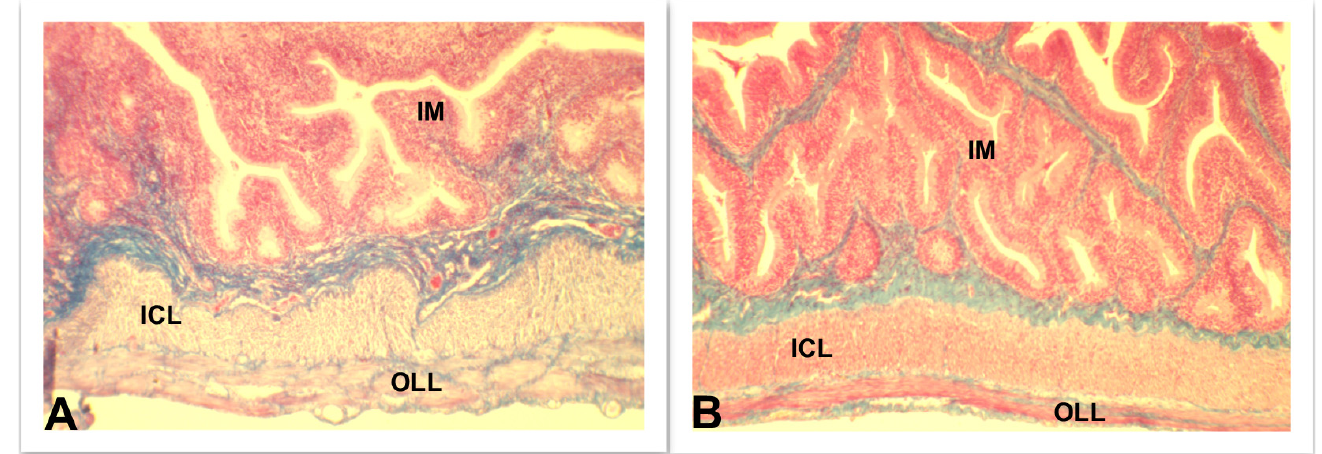
Figure 2. Light micrographs of the intestine of Anguilla anguilla . Mallory staining. ( A ) Control and ( B ) exposed specimens. In control specimens, the intestinal mucosa (IM) showed signs of histolysis, whereas the muscular layers, inner circular layer (ICL) and outer longitudinal layer (OLL), showed